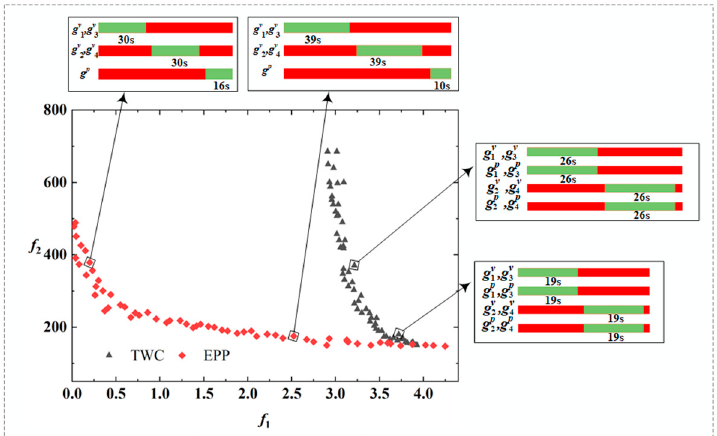
Figure 5. The nondominated front and signal timing pattern under EPP and TWC conditions.